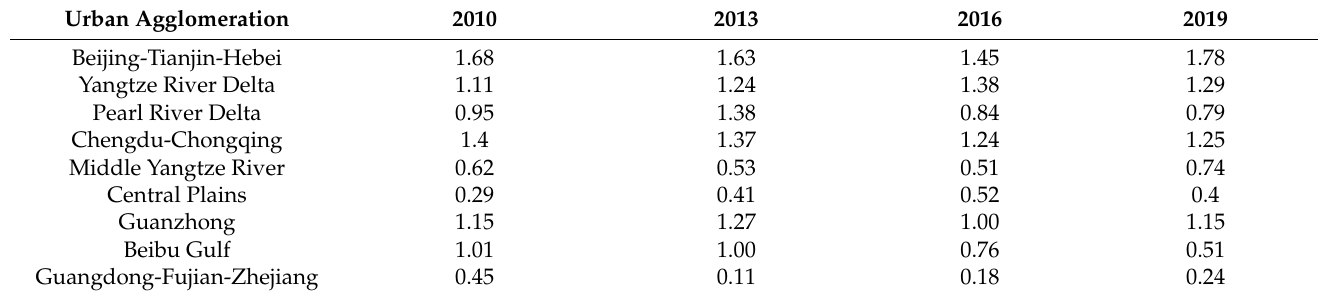
Table 2. Scaling exponents of industrial land of night t urban agglomerations in China,